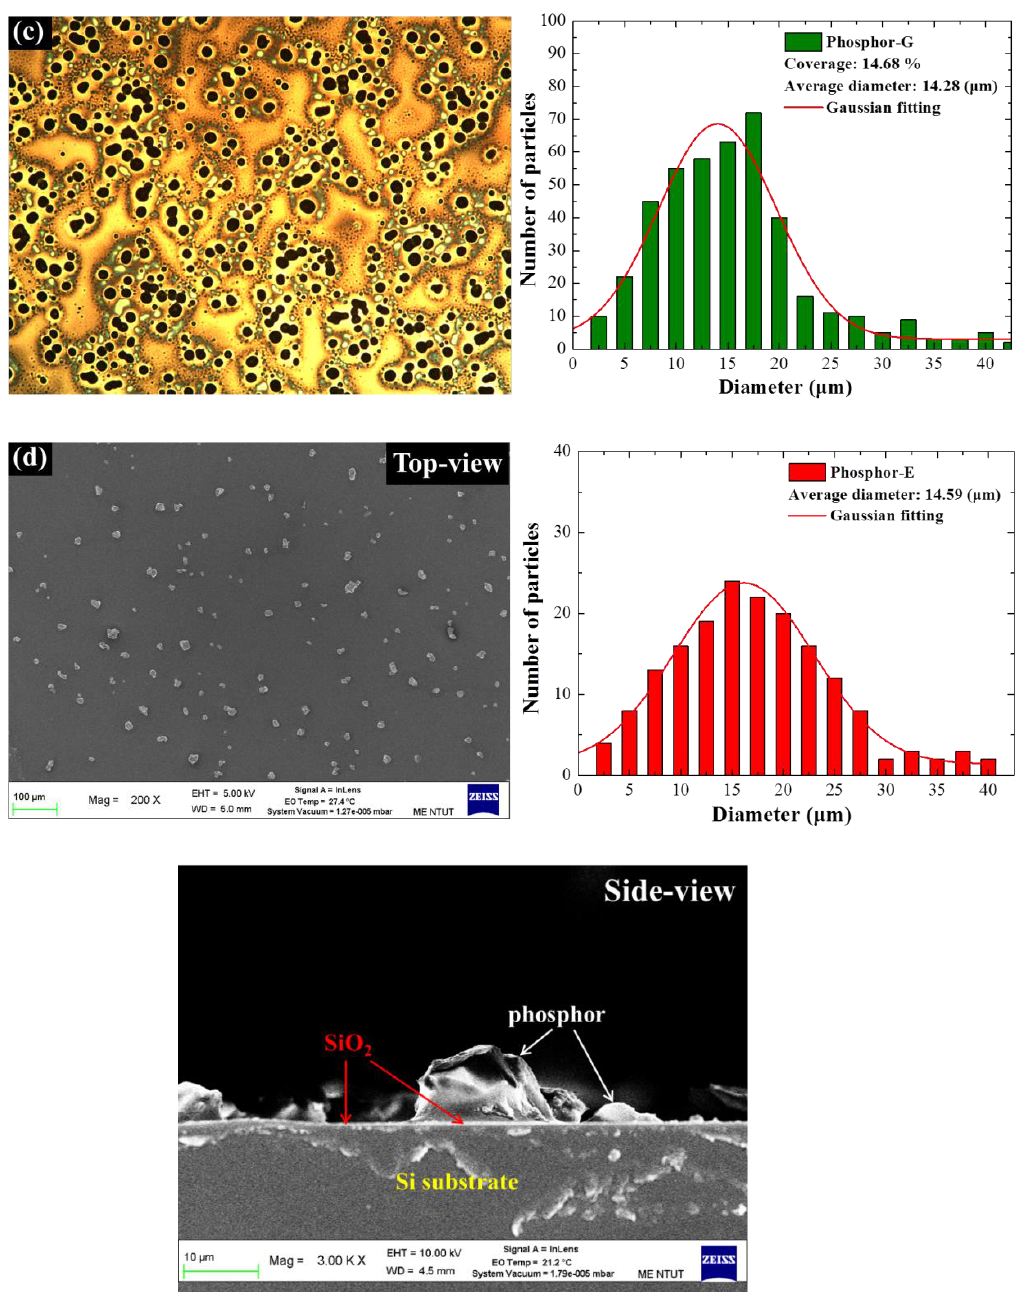
Figure 2. Optical images and particle-size distributions of single-phosphor samples: ( a ) Phosphor-E, ( b ) Phosphor-F, and ( c ) Phosphor-G; ( d ) SEM images (top and side views) of the silicon wafer coated with SiO 2 and phosphor particles.